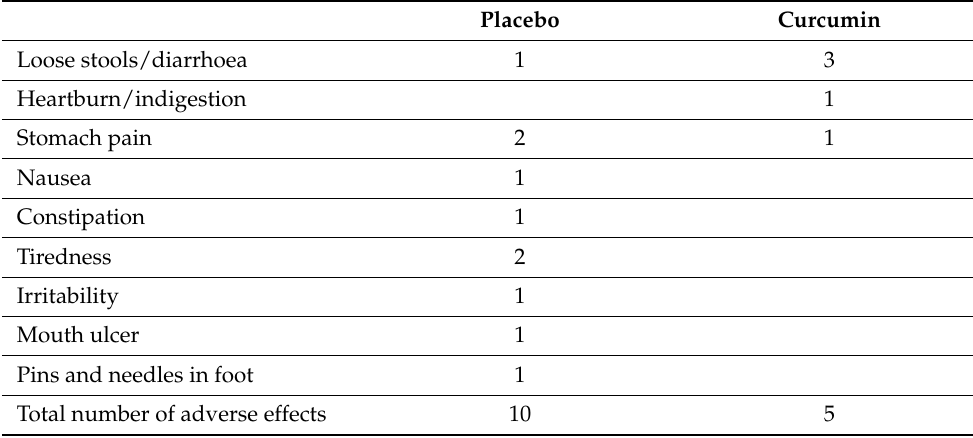
Table 6. Frequency of self-reported adverse